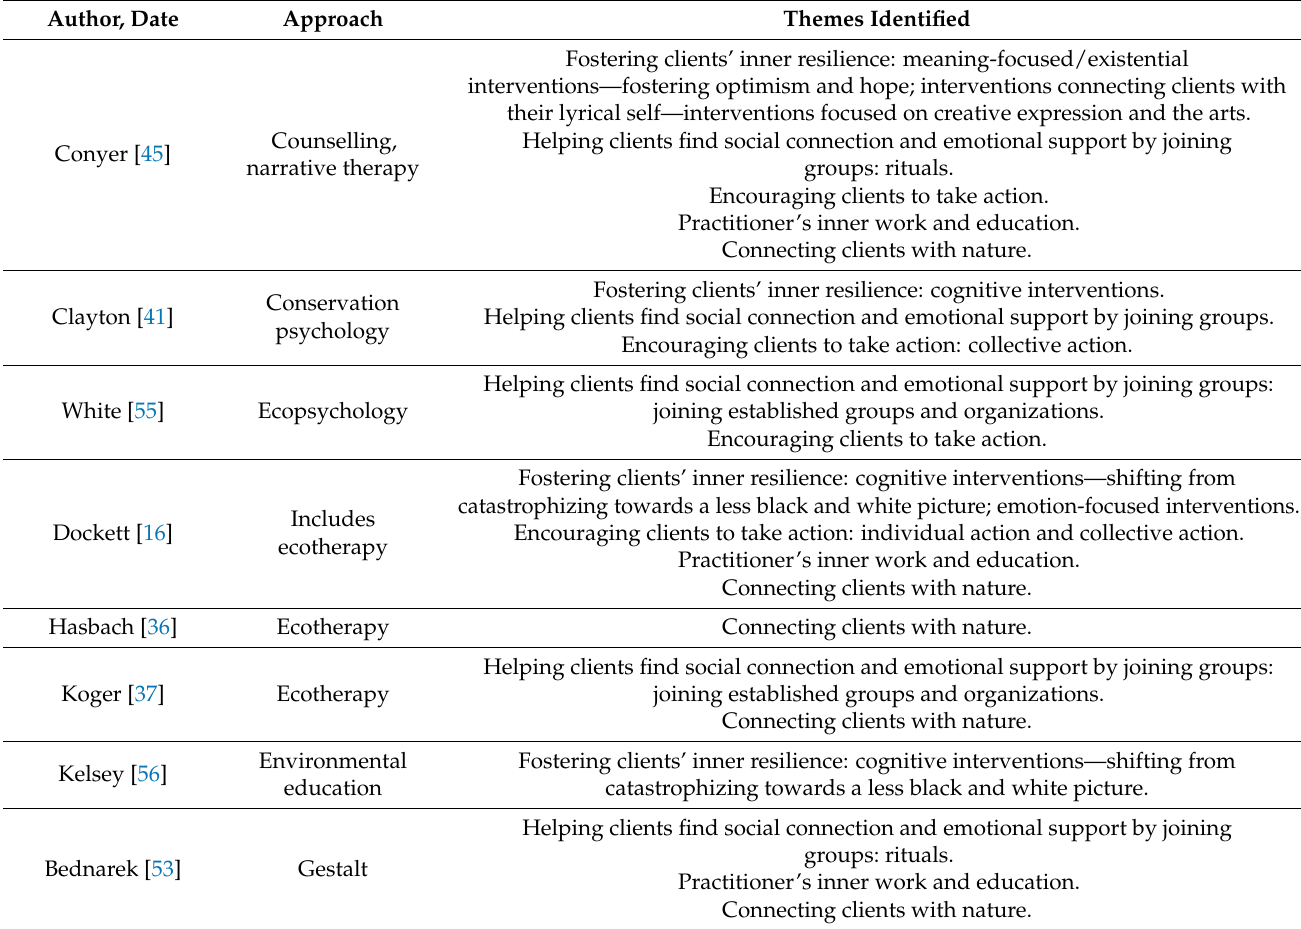
Table 2. Intervention themes, sub-themes, and sub-sub themes identified in scoping